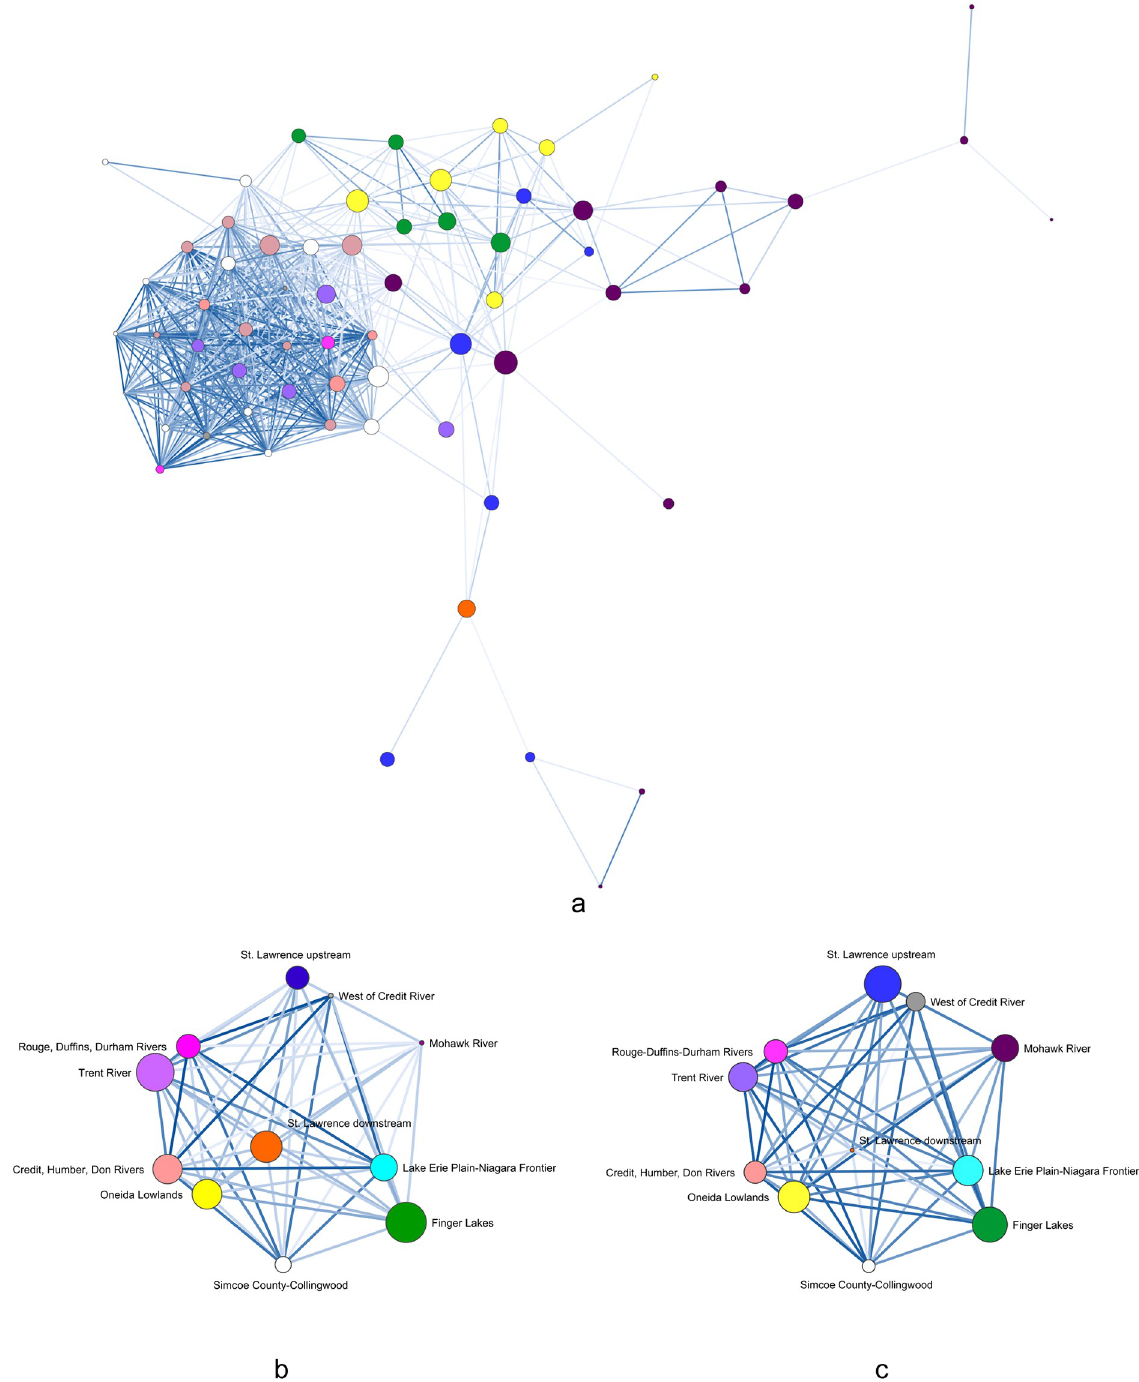
Fig 7. AD 1500–1600 network visualizations. (a) BR site-level network with threshold of � 0.50 and spring embedder layout, (b) weighted BR centroid network with MMDS layout, (c) weighted LCP similarity centroid network with MMDS layout. Node size based on potential brokerage